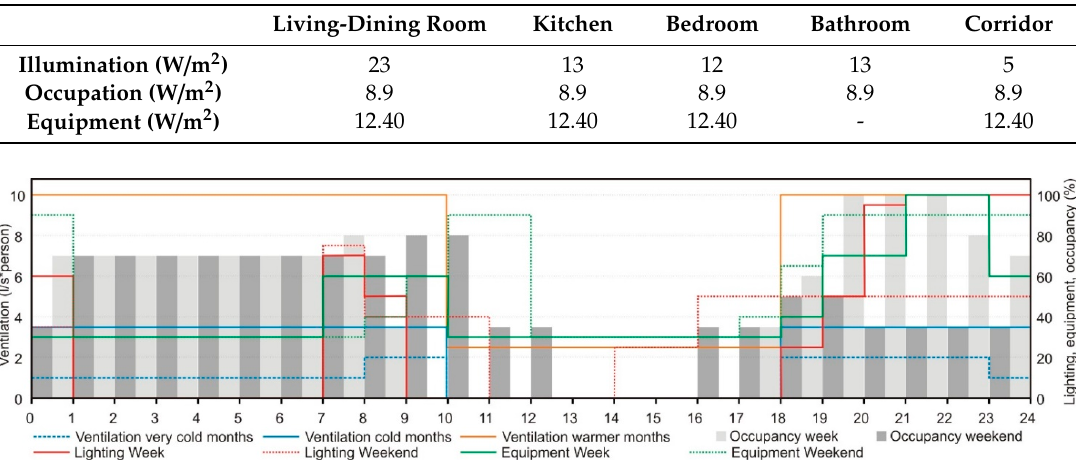
Figure 4. Occupation, lighting and equipment and ventilation schedules. Source: [34].